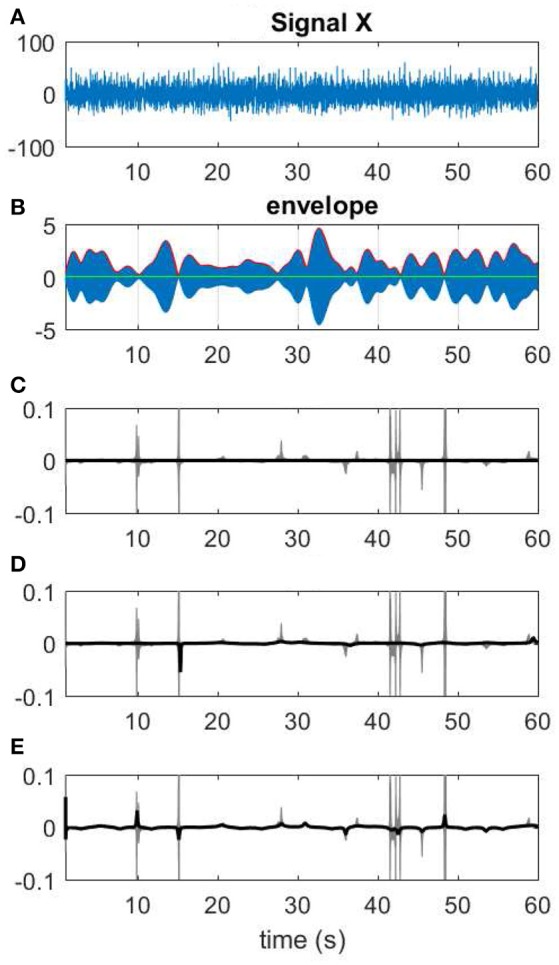
Different choices of Kalman smoothing factor. (A) A 60-s segment of EEG measurement. (B) The narrow band-passed signal along with its envelope. (C) The extreme case of zero factor yields a line for IF. (D) A factor of 0.005. (E) IF resulting from a high factor >100.